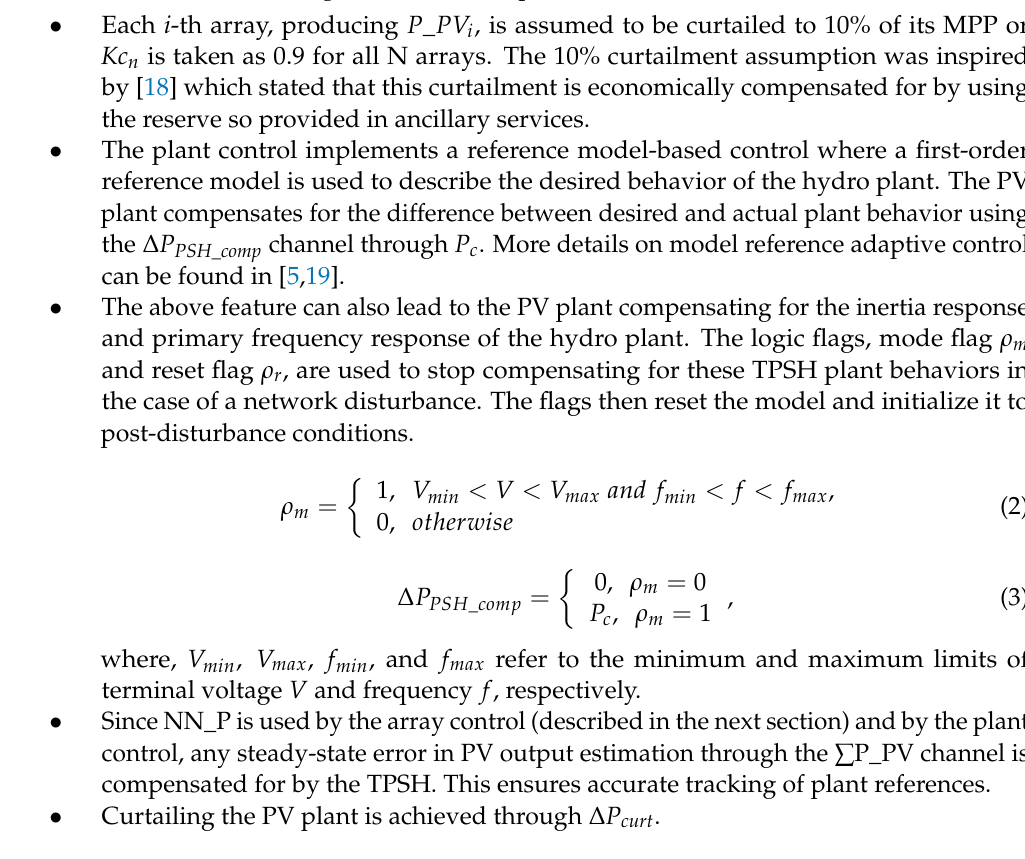
Figure 3. Schematic of the hybrid PV–TPSH plant control. The plant control estimates the PV generation using NN_P and the array’s curtailment gain Kc n , where NN_P is a neural network emulating the maximum output power of each array (as the output of the NN_P) given the solar irradiance, G, and temperature, T, as inputs. As shown in Figure 3, the plant control utilizes the PV plant reserve and control capability for (a) compensating for sudden changes in insolation through ∆ P PV_comp , (b) compensating for hydro plant nonlinear behavior through ∆ P PSH_comp and, (c) curtailing the PV plant through ∆ P curt . The TPSH is used mainly for (a) firming slow disturbances in PV output, and (b) generation shifting. Both PV and TPSH system participate in voltage control. Some of the design features of the plant control are as